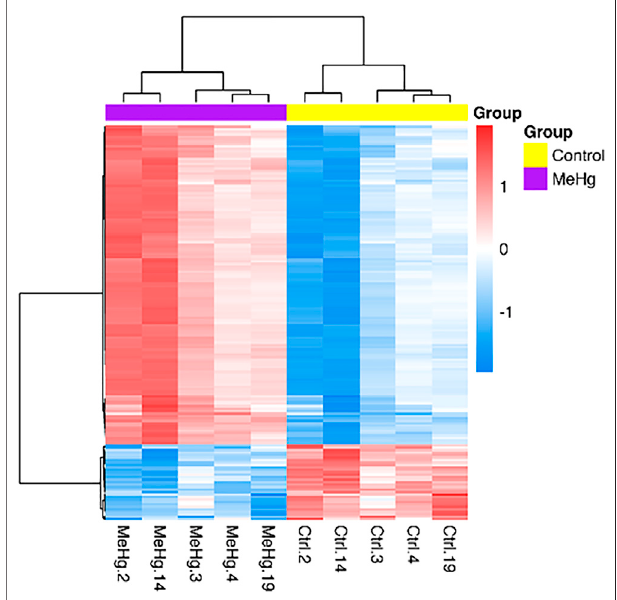
FIGURE 2 | Global pro fi le of gene expression of the exposed human salivaryglandcellslineto2.5 µMofMeHgvs.nonexposedcells.Thebluedots in the volcano plot represent downregulated genes, and red dots represent upregulated genes. Data were expressed as log2FC > 1 or < − 1 and analyzed by t -Student test, adopting adj. p < 0.01 ( n (cid:2) 5/each